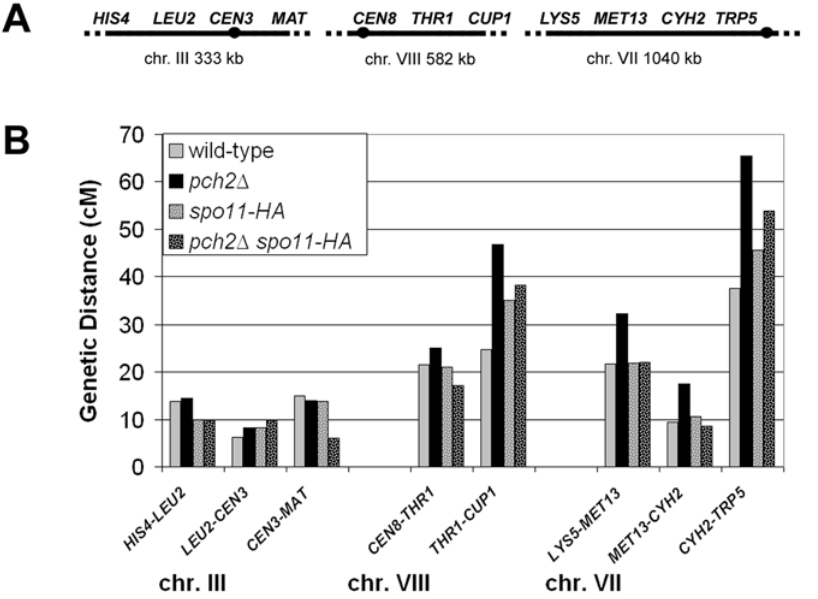
Figure 2. pch2 D has increased meiotic CO levels on chromosomes VII and VIII, but not the small chromosome III. (A) The organization of genetic markers assayed on a small (III), medium (VIII), and large (VII) chromosome in the NHY942/NHY943 strain background is shown. (B) CO frequencies in cM were calculated from four-spore viable tetrads in wild-type, pch2 D /pch2 D , spo11-HA/spo11-HA and pch2 D spo11-HA/spo11-HA strains. See Table 1 for raw data and statistical